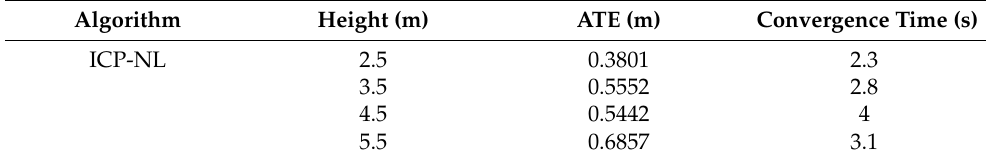
Table 9. Truck simulation position estimation errors for ICP-NL algorithms for different altitudes.